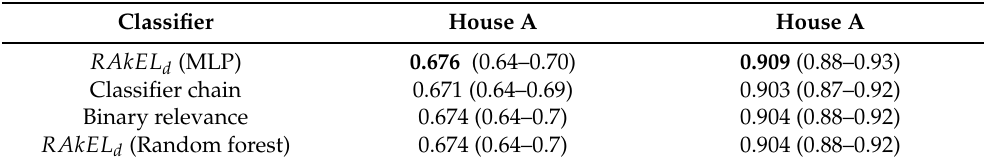
Table 4. Average F1 score per classifier. Inside the parentheses is the confidence interval (96% confidence). The best value can be seen in bold.